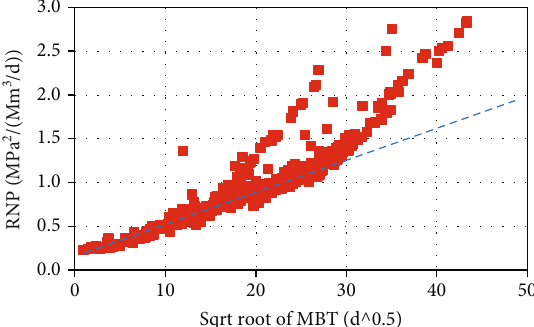
Figure 7: Linear analysis curve.